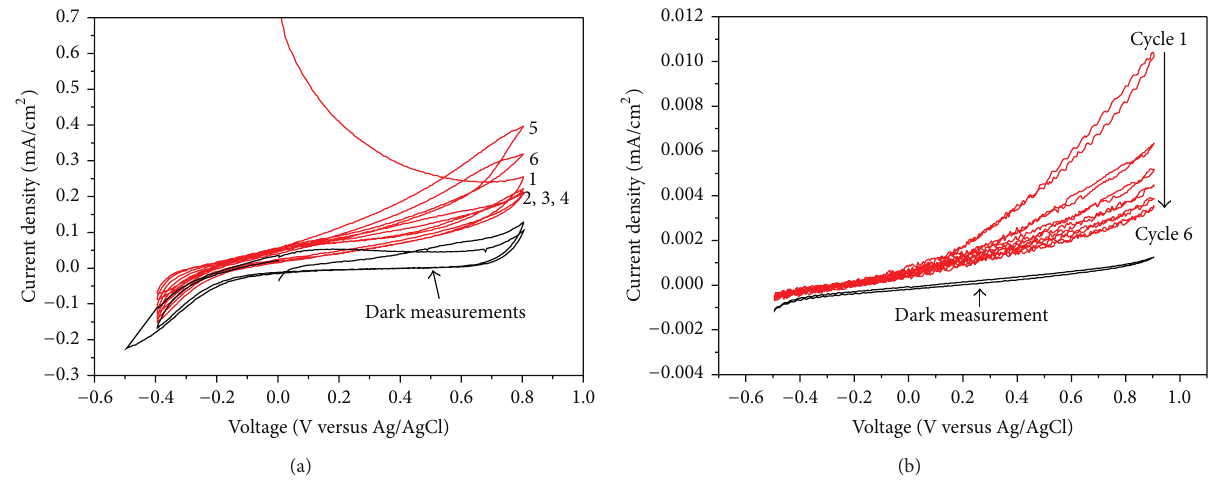
Figure 3: 𝐼 - 𝑉 curves in 0.1M KOH solution of CdS films coated with 30 (a) and 60 (b) ALD cycles of TiO 2 . Scan rates were 100mV/s. Red lines represent photocurrent measurements and black lines dark measurements.